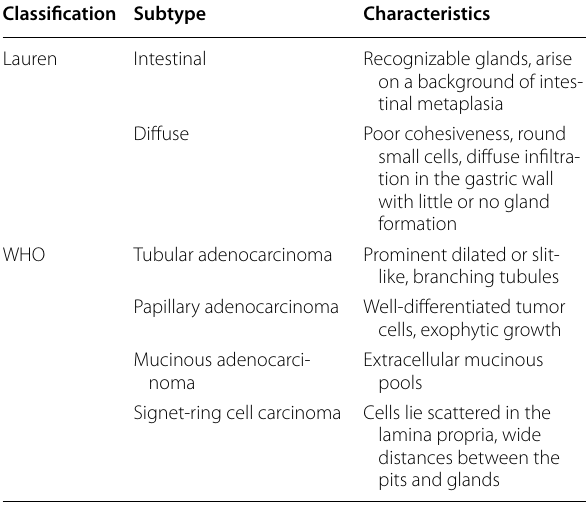
WHO the World Health Organization